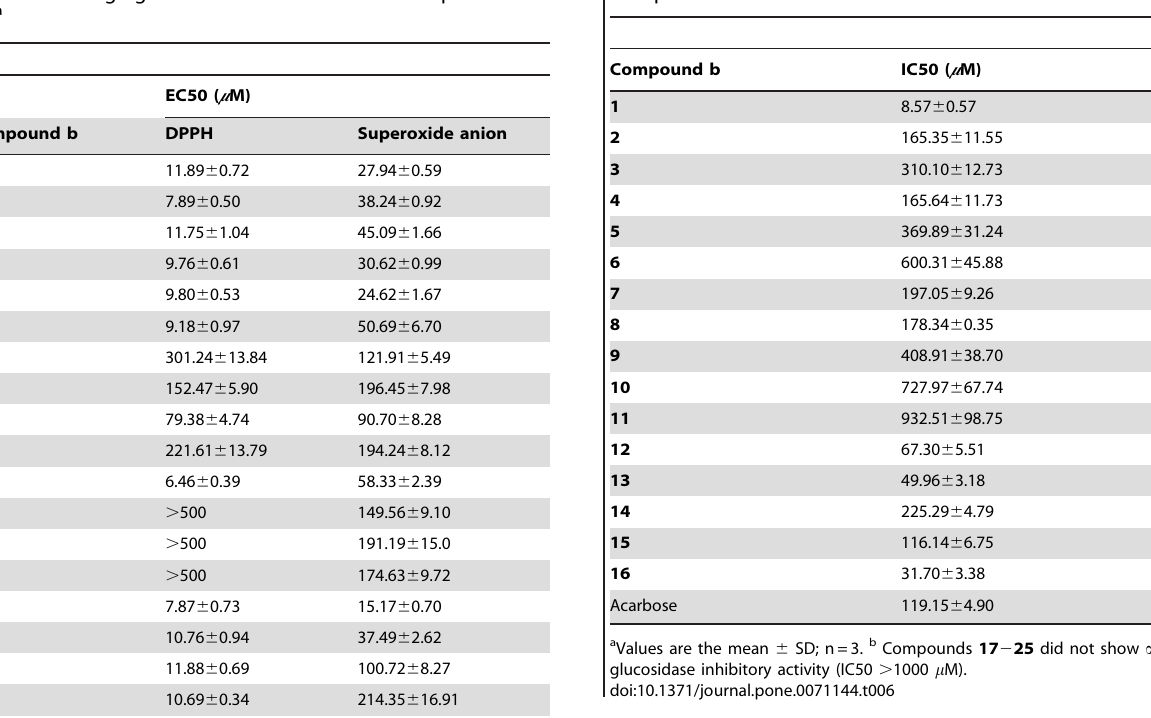
Table 6. a -Glucosidase Inhibitory Activities of the